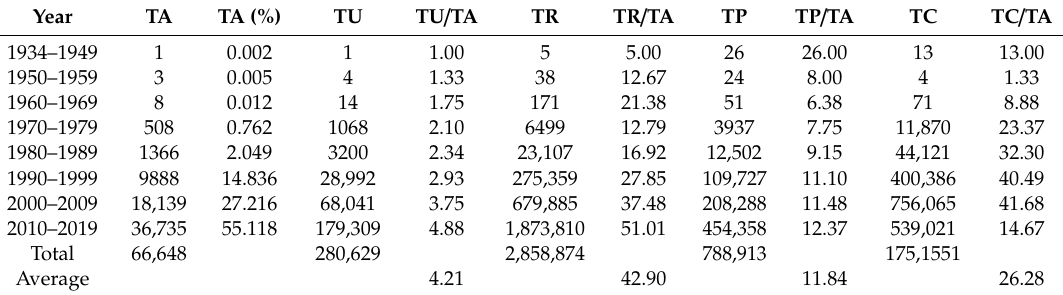
Table 1. Characteristics of article output from 1934 to